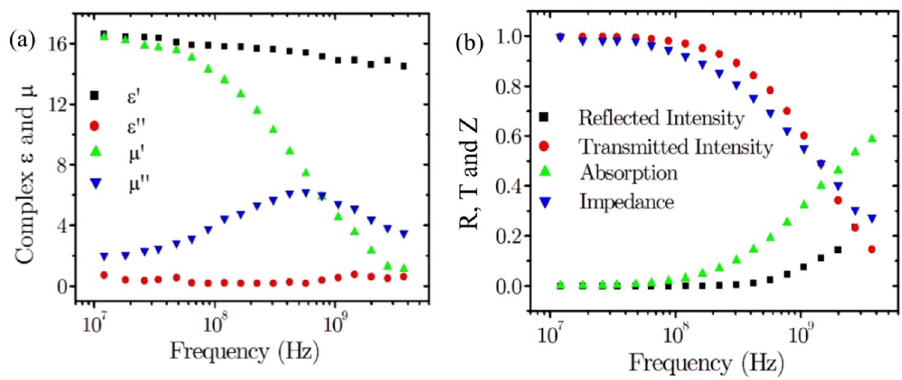
Figure 4. ( a ) Plot of the complex relative permeability and permittivity as a function of frequency and ( b ) reflected and transmitted intensity, absorption and the relative impedance as a function of frequency for a 65% vol. NiZn ferrite, 15% vol. MnZn ferrite and 20% vol. PTFE